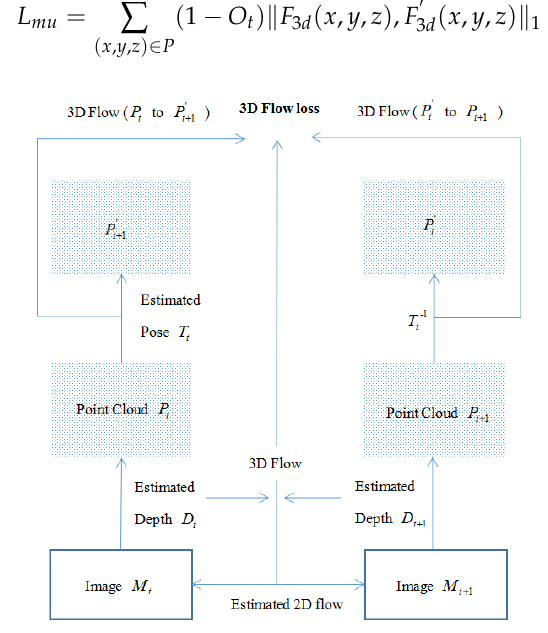
Figure 2. The 3D Flow is computed for both directions. The loss takes utilization of estimated depth, optical flow and camera